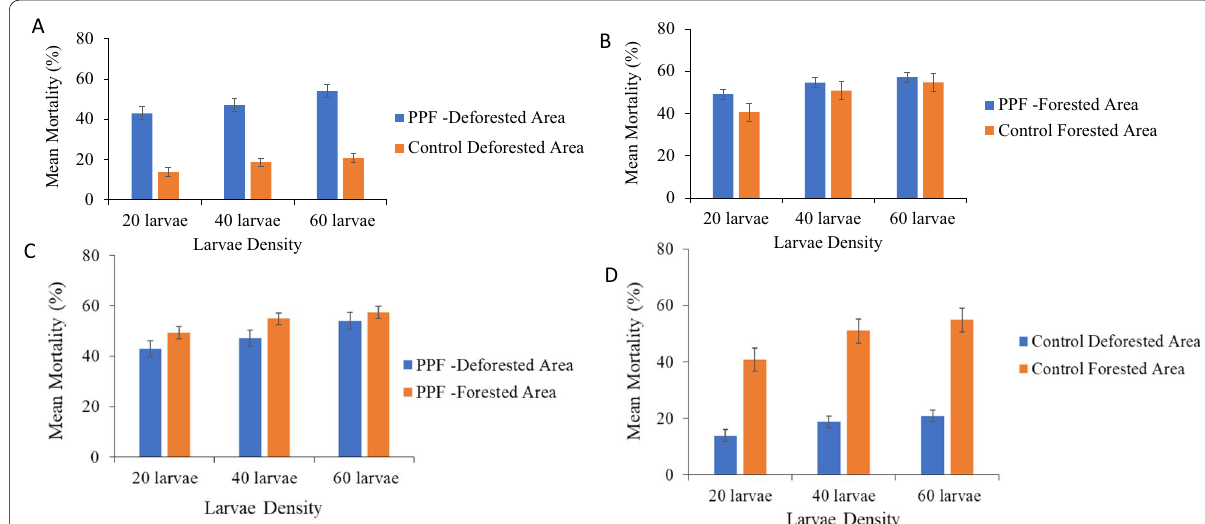
Fig. 2 The impact of Pyriproxyfen at 0.3 ppm on An. gambiae s.s. mortality rates between forested and deforested area A – C at densities of 20, 40 and 60 larvae and Comparison of larvae mortality in control D (experiments were repeated 6 times in 3 rounds)